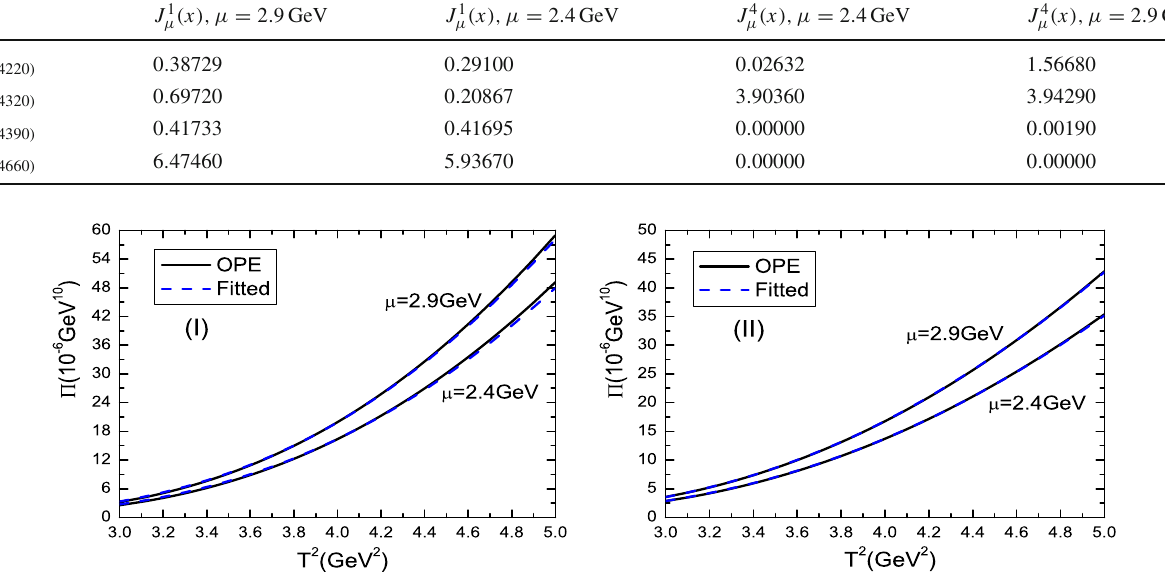
Fig. 4 The correlation functions with the central values of the fitted pole residues compared to the operator product expansion (OPE), where the (I) and (II) denote the currents J 1 μ ( x ) and J 4 μ ( x ) ,